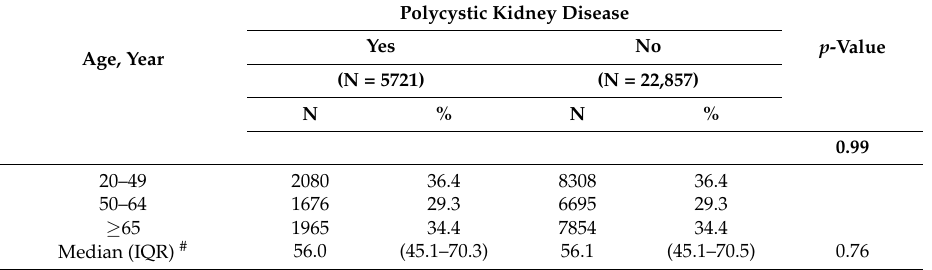
Table 1. Characteristics of patients between patients with and without polycystic kidney disease (PKD).